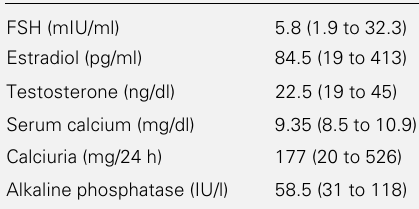
Table 3 - Hormonal and biochemical parameters of premenopausal women who participated in the